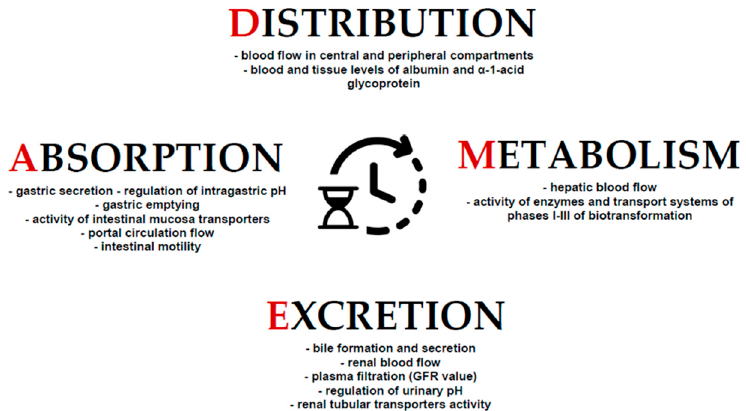
Figure 2. The summary of examples of chronobiological physiological phenomena that determine pharmacokinetic processes. The stages of ADME are controlled by phenomena characterized by the daily variability of their activity.